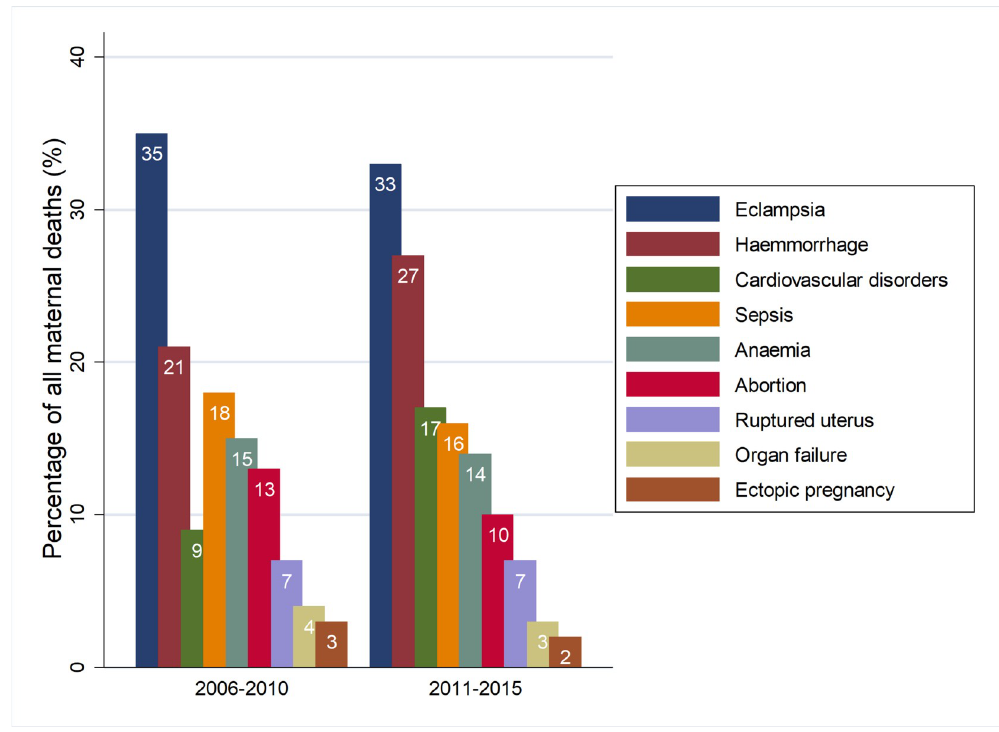
Fig 8. Comparison of the proportion of all major causes of maternal related deaths between the 2006–2010 and 2011– 2015 periods (2006–2010: n = 755; 2011–2015:n =